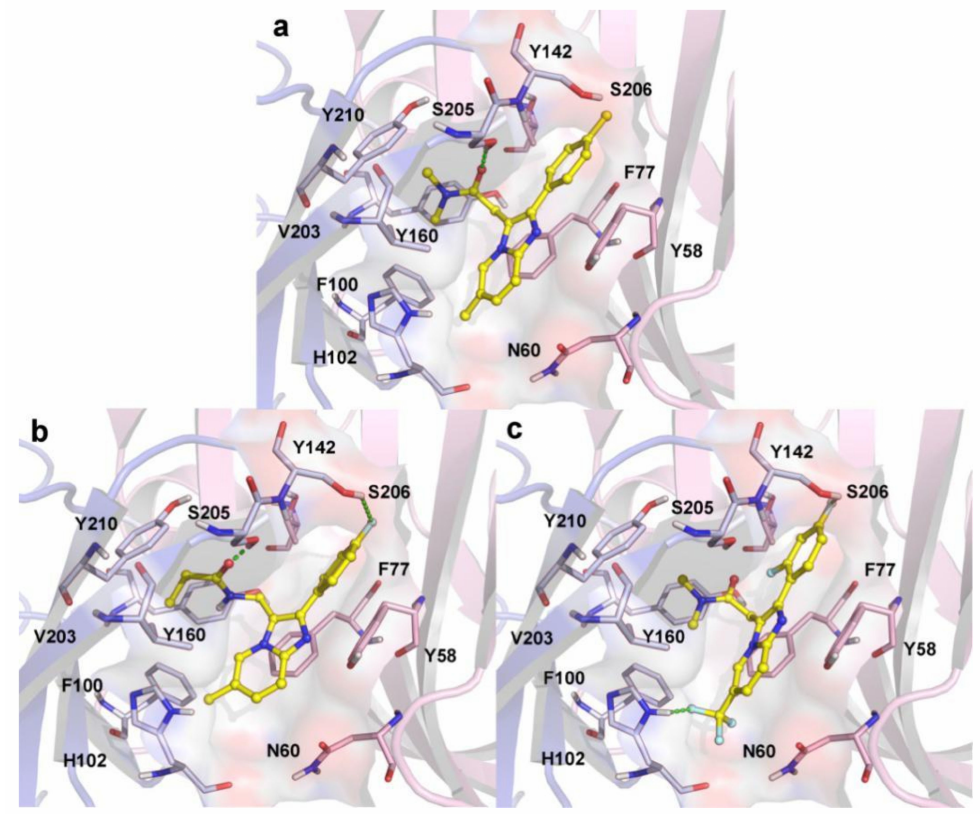
Figure 8. The docking results of zolpidem ( a ), compound 14 ( b ), and compound 8 ( c ) in the binding site of human α 1 β 2 γ 2 GABA A R (PDB ID: